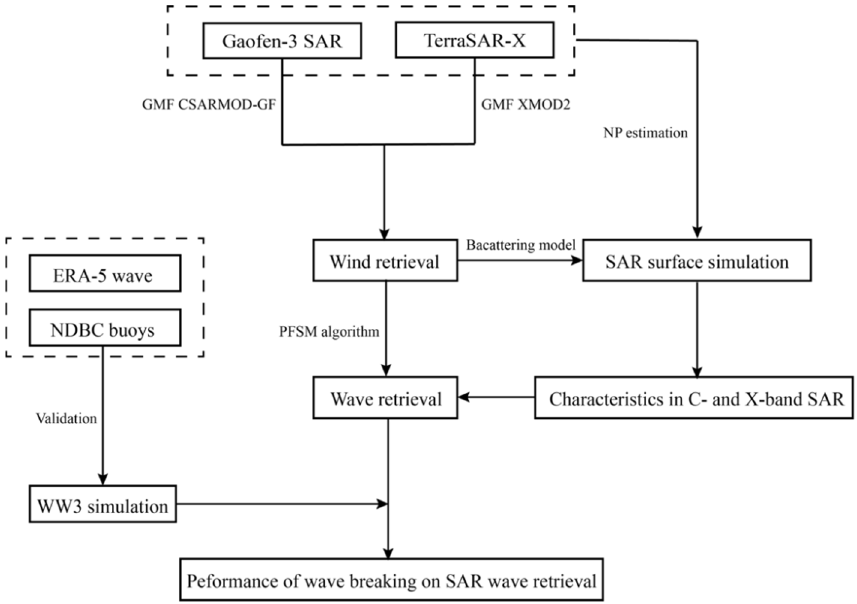
Figure 6. Flowchart of the study of the performance of wave breaking on SAR wave retrieval.